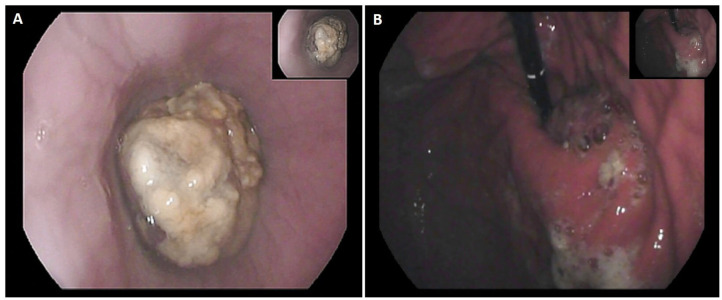
Endoscopic view: (A) proximal tumor margin; (B) retroflexed view of the cardia.